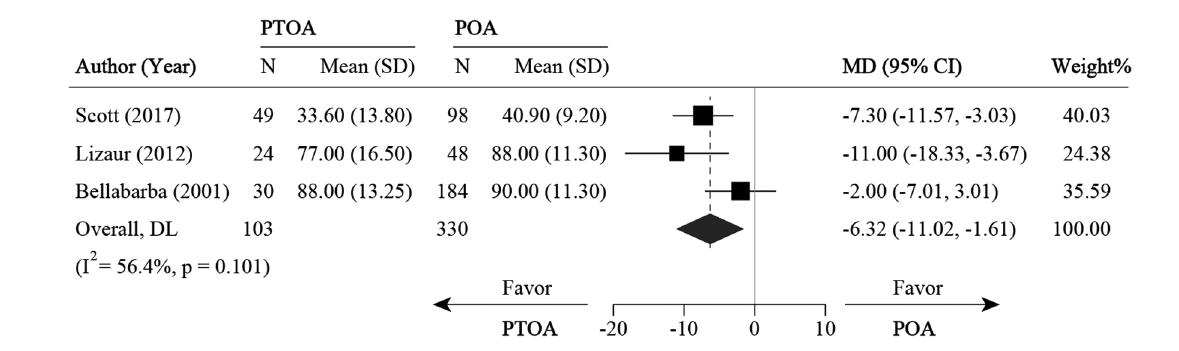
FIGURE 10 Meta-analysis for HHS and OHS comparison between PTOA and POA. HHS, harris hip score; MD, mean difference; OHS, oxford hip score; PTOA, post-traumatic osteoarthritis; POA, primary osteoarthritis; SD, standard deviation.